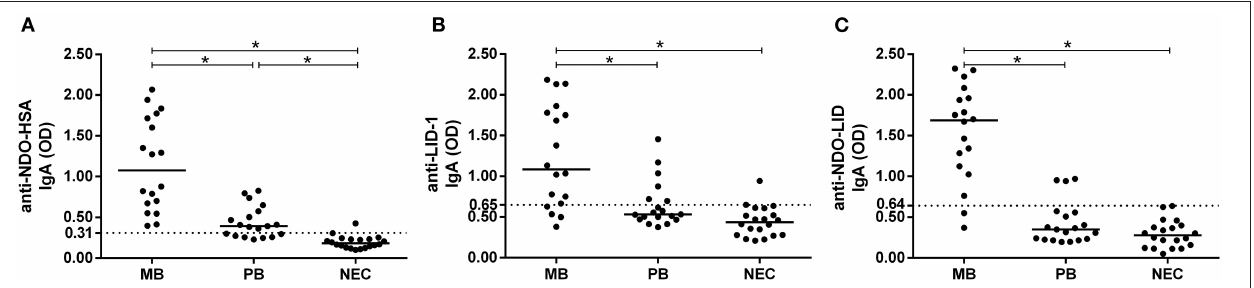
FIGURE 1 | Antigen-specific IgA responses in multibacillary (MB) and paucibacillary (PB) leprosy. Levels of IgA antibodies against (A) NDO-HSA, (B) LID-1, and (C) NDO-LID in serum of MB ( n = 18) and PB ( n = 19) leprosy patients and in non-endemic controls (NEC; n = 20) were measured by ELISA. The cut-off point (dashed line) was established by the ROC curve while the horizontal bars represent median. * = P < 0.05.